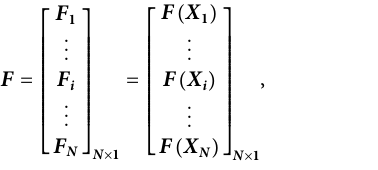
where X is the population matrix of ospreys ’ locations, X i is the i th osprey (a candidate solution), x i,j is its j th dimension (problem variable), N is the number of ospreys, m is the number of problem variables, r i,j are random numbers in the interval [ 0 , 1 ] , lb j , and ub j are the lower bound and upper bound of the j th problem variable, respectively Because each osprey is a candidate solution for the problem, corresponding to each osprey, the objective function can be evaluated. The evaluated values for the objective function of the problem can be represented using a vector according to (3).